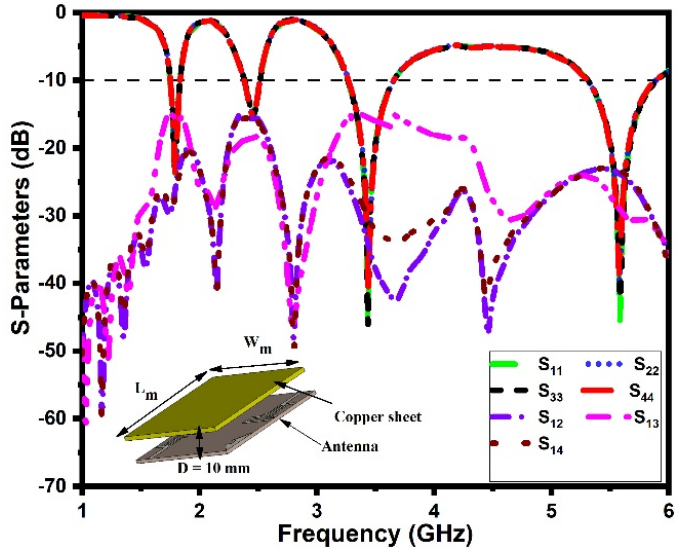
Figure 14. S − parameters under the copper sheet.